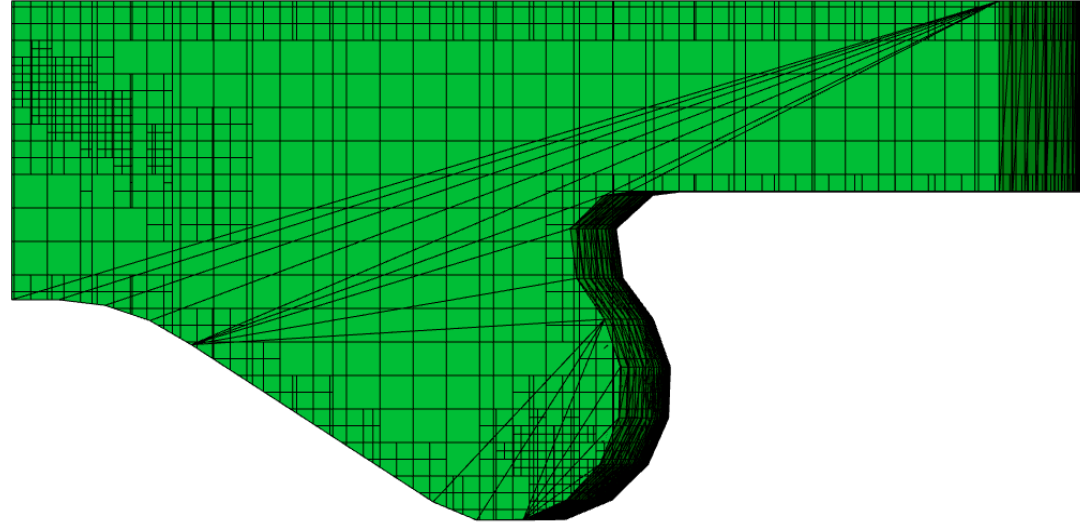
Figure 1. The geometric model of the combustion chamber in the CONVERGE environment.